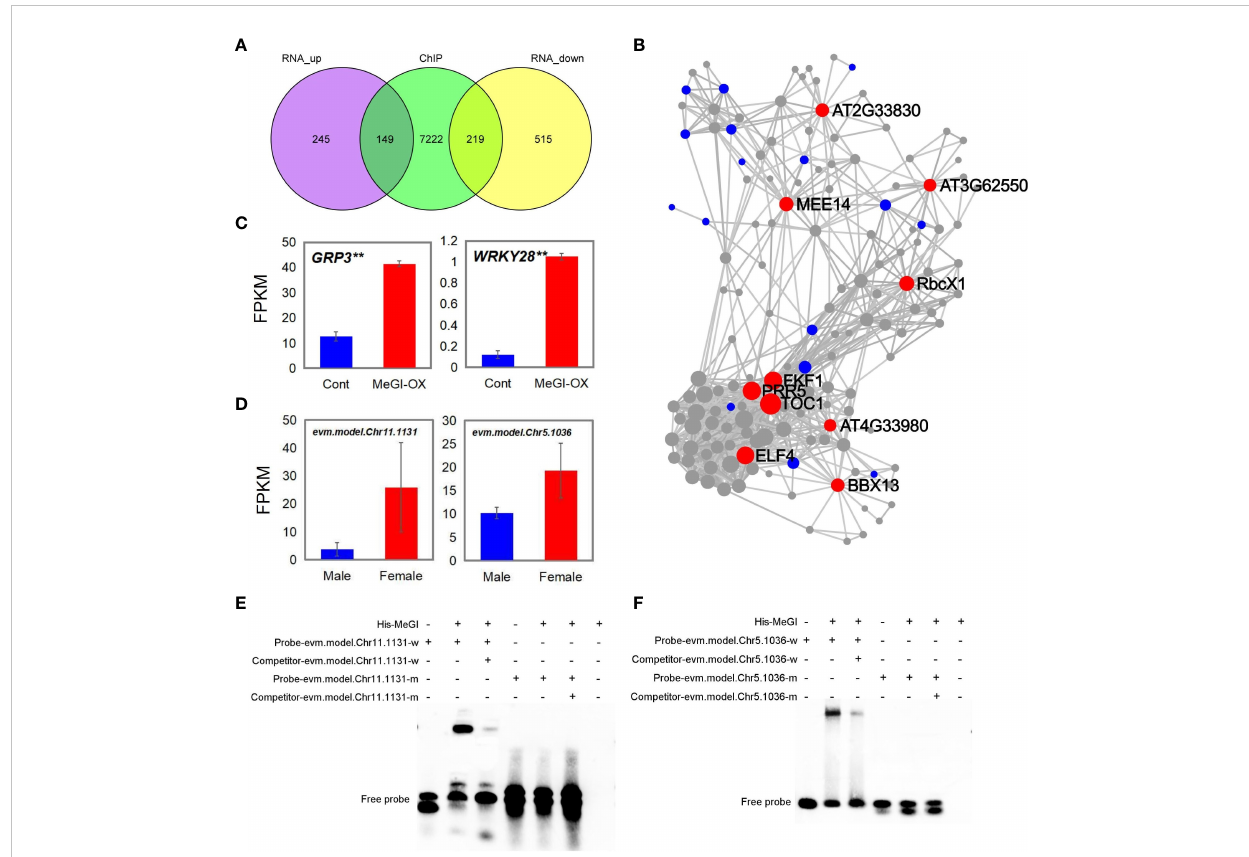
FIGURE 6 Genes shared among the ChIP-seq, RNA-seq and DAP-seq results. (A) Genes shared between ChIP-seq and RNA-seq analyses. (B) KDA of 149 upregulated genes; red, blue, and gray circles represent the key driver, initial, and associated genes, respectively. (C, D) Fragments per kilobase of transcript per million mapped reads (FPKM) of the shared genes in the ChIP-seq, RNA-seq, and DAP-seq data in MeGI-OX lines and control lines (C) , and in female and male fl ower buds of D . oleifera (D) . Bars indicate standard errors. (E, F) EMSA results con fi rming that MeGI directly bound to the motifs of the evm.model.Chr11.1131 ( GRP3 ) (E) and evm.model.Chr5.1036 ( WRKY28 ) (F)